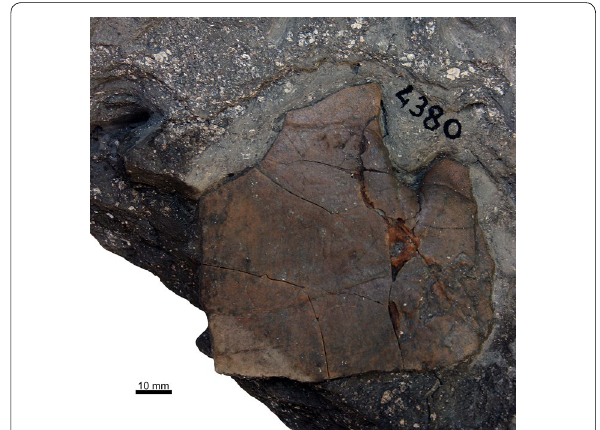
Fig. 6 Mauremys sp. from Cessaniti. Left hyoplastron (MSNC 4380) in ventral